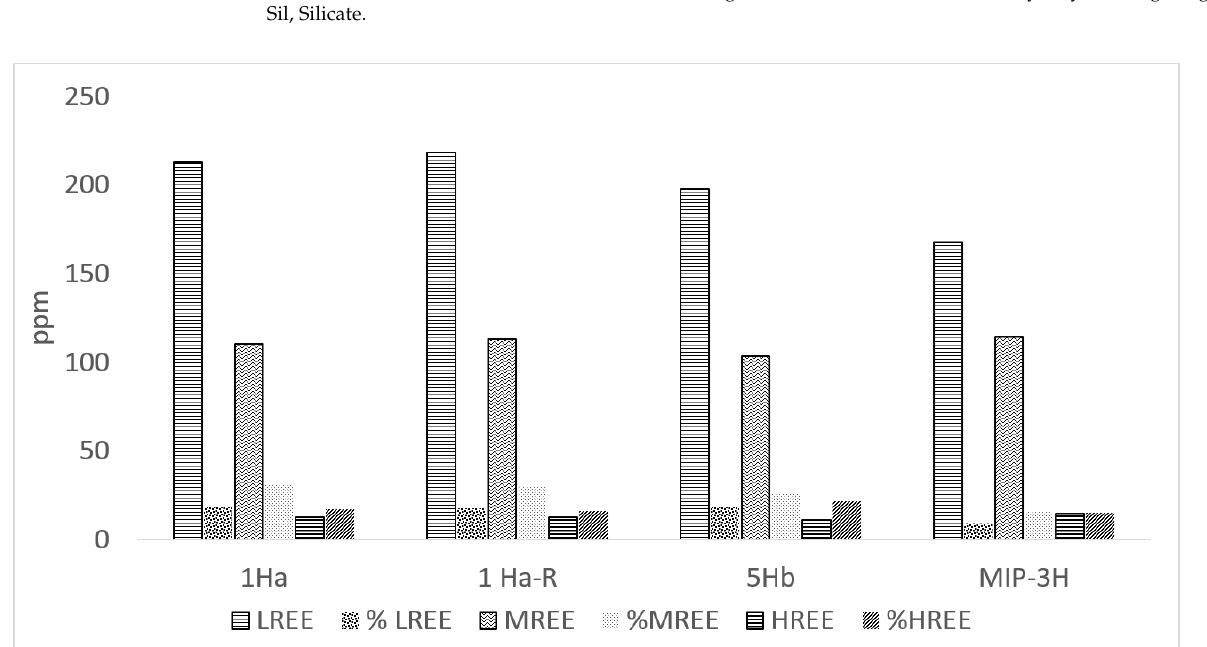
Figure 5. Total REY distribution in the extracted rock fractions. 0%10% 20%30%40% 50% 60% 70% 80%